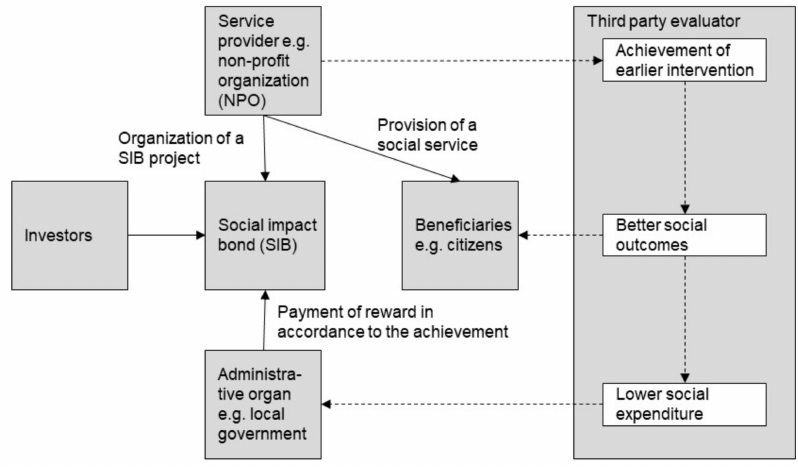
Figure 1. General structure and scheme of a social impact bond